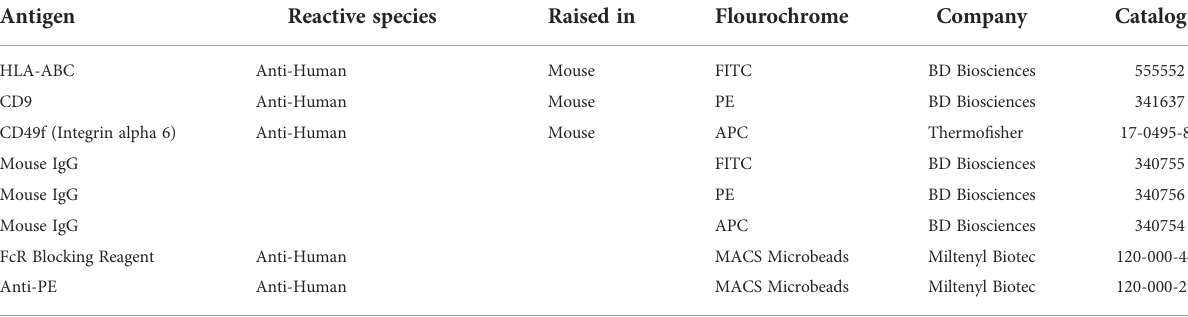
TABLE 3 Antibodies used for Flow cytometry and Magnetic-activated cell sorting (MACS).